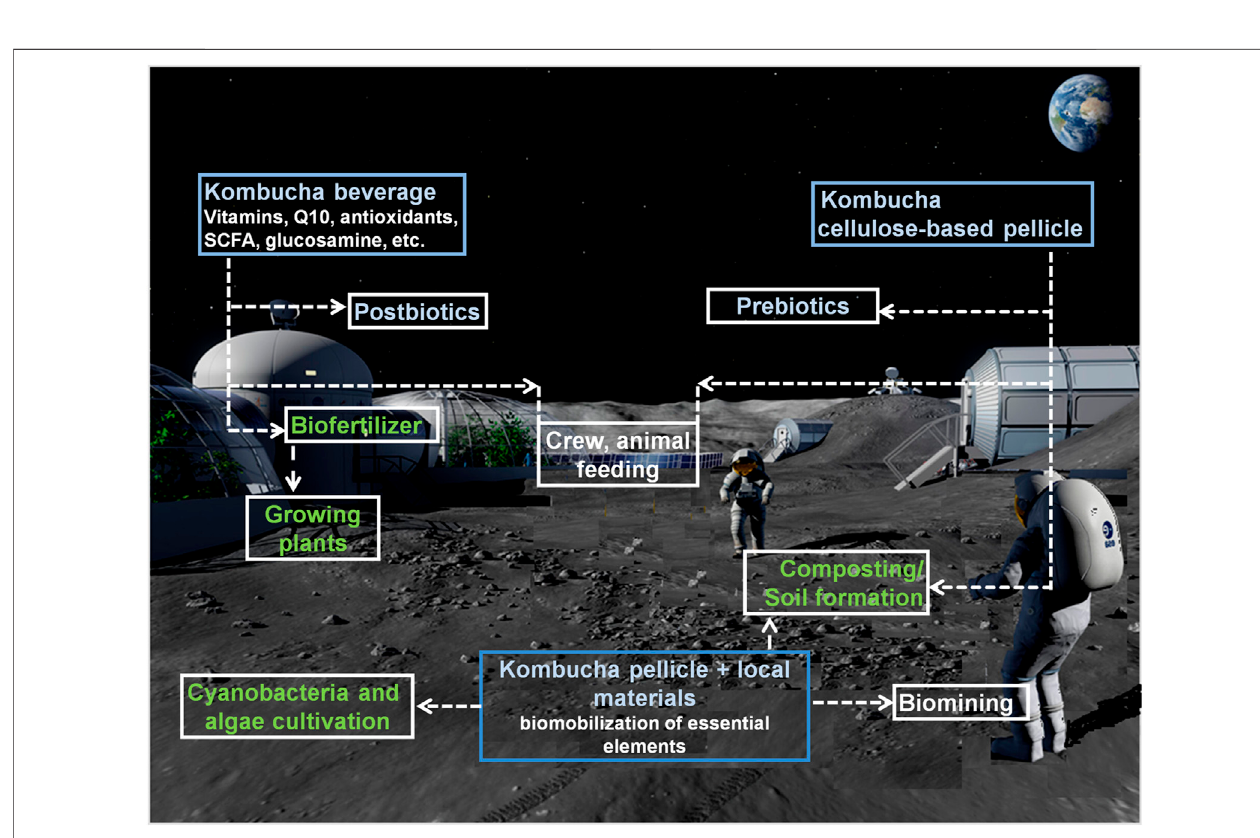
FIGURE 3 | A schematic presentation of different approaches for manipulation of the kombucha microbial community to enhance life-support ef fi cacy in extraterrestrial settlements.